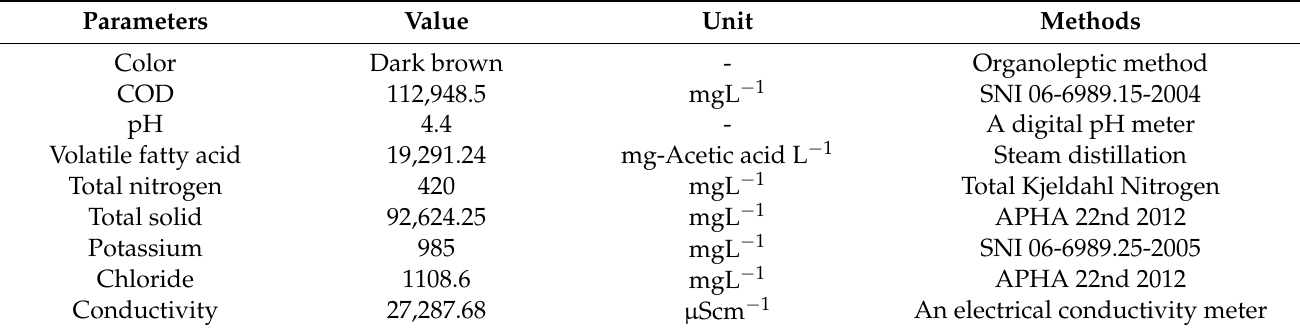
Table 1. Chemical characteristics of the distillery spent wash